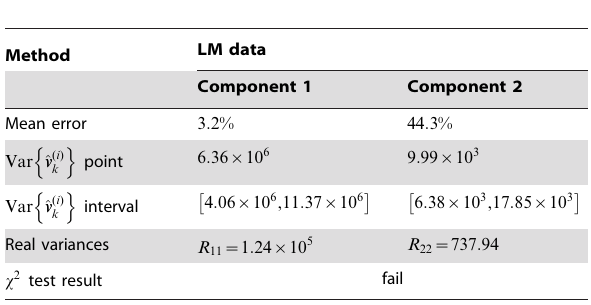
Table 3. x 2 test results for the estimation of 6 parameters in the heat shock model (nonlinear least-squares).